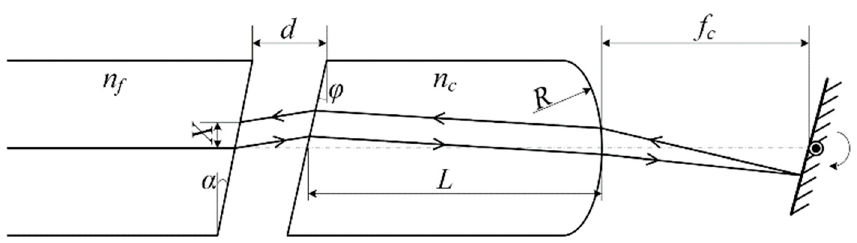
Figure 2. Optical model of the VOA in side view.